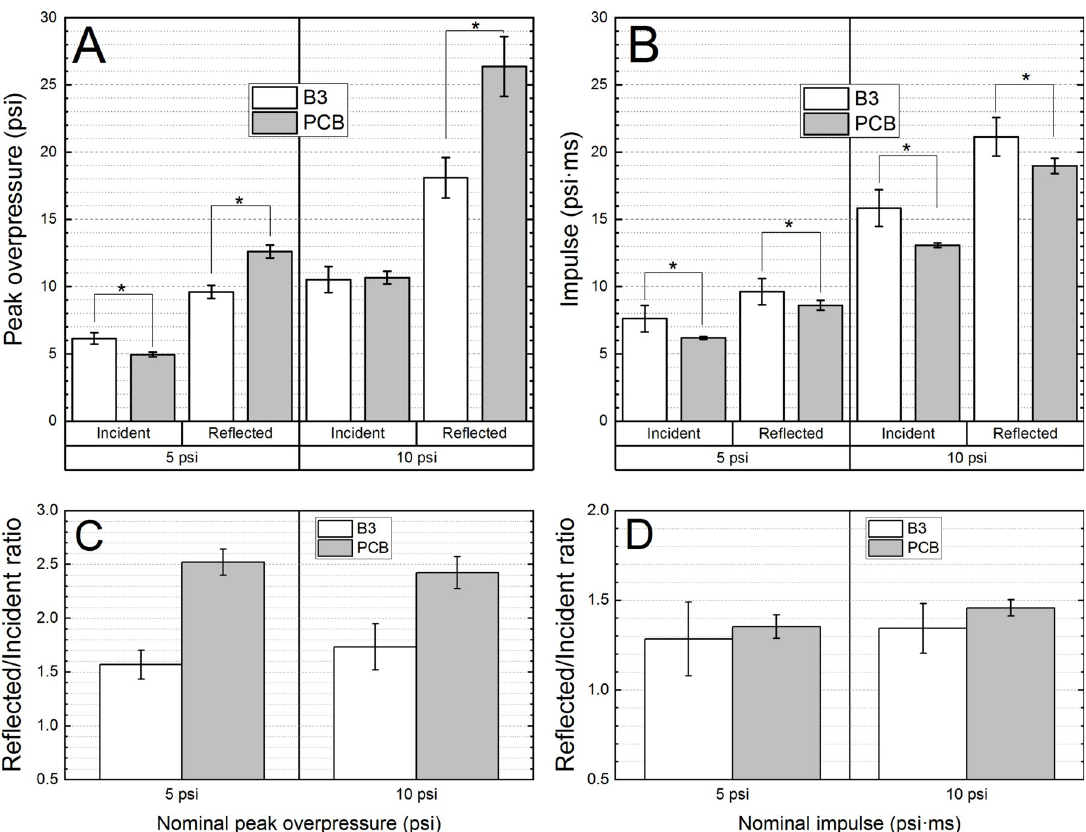
Fig 2. The results of the quantification of the incident and reflected pressure measurements for the B3 Blast Gauge sensors with the PCB sensors used as a reference. The average peak overpressure (A) and impulse (B) and reflected-to-incident peak overpressure (C) and impulse (D) ratios were compared. The statistical significance is marked with an asterisk (p <